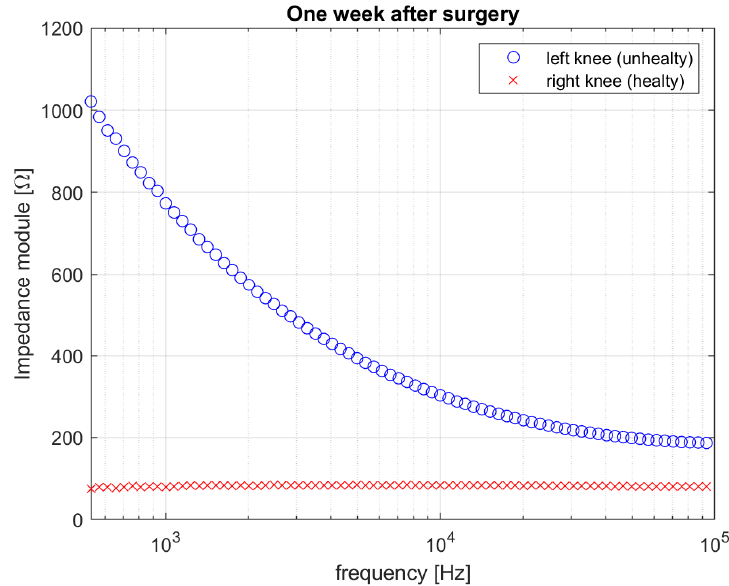
Figure 7. Impedance magnitude value for both right (healthy) and left (unhealthy) knee one week after surgery.